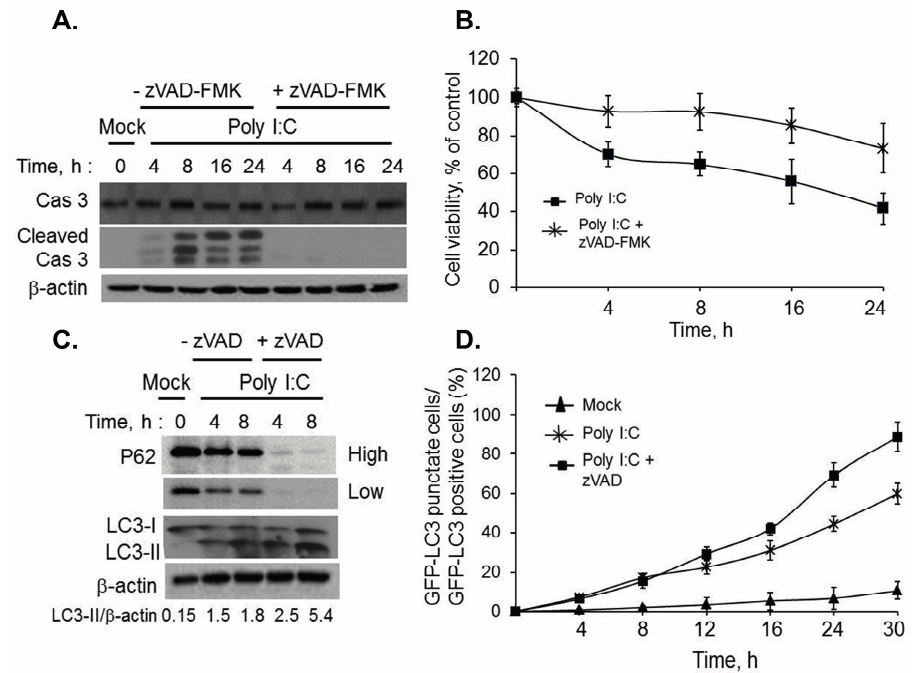
Figure 2. Regulation of autophagy by inhibiting dsRNA-induced apoptosis. HT1080 cells were pretreated with zVAD-FMK (20 µM) or not for 1h followed by 2 µg/mL of PolyI:C for indicated times. ( A ) Cleavage of caspase 3 was determined on immunoblots and normalized to β -actin levels; ( B ) cell viability was determined by MTT assay and normalized to control cells. Results are representative of three independent experiments performed in triplicate ± SD; ( C ) Conversion of unconjugated LC3-I to lipidated LC3-II and degradation of p62 was monitored on immunoblots and normalized to β -actin levels. Band intensity was calculated using Image J software and ratios of LC3-II/ β -actin was determined. Results are representative of three independent experiments; ( D ) GFP-LC3 expressing HT1080 cells were pretreated with zVAD-FMK (20 µM) or not for 1 h followed by 2 µg/mL of PolyI:C or mock treated for indicated times. The percentage of GFP + cells showing puncta formation compared to mock treated cells was analyzed. Results shown represent mean ± SEM for three experiments and at least 100 cells were analyzed per